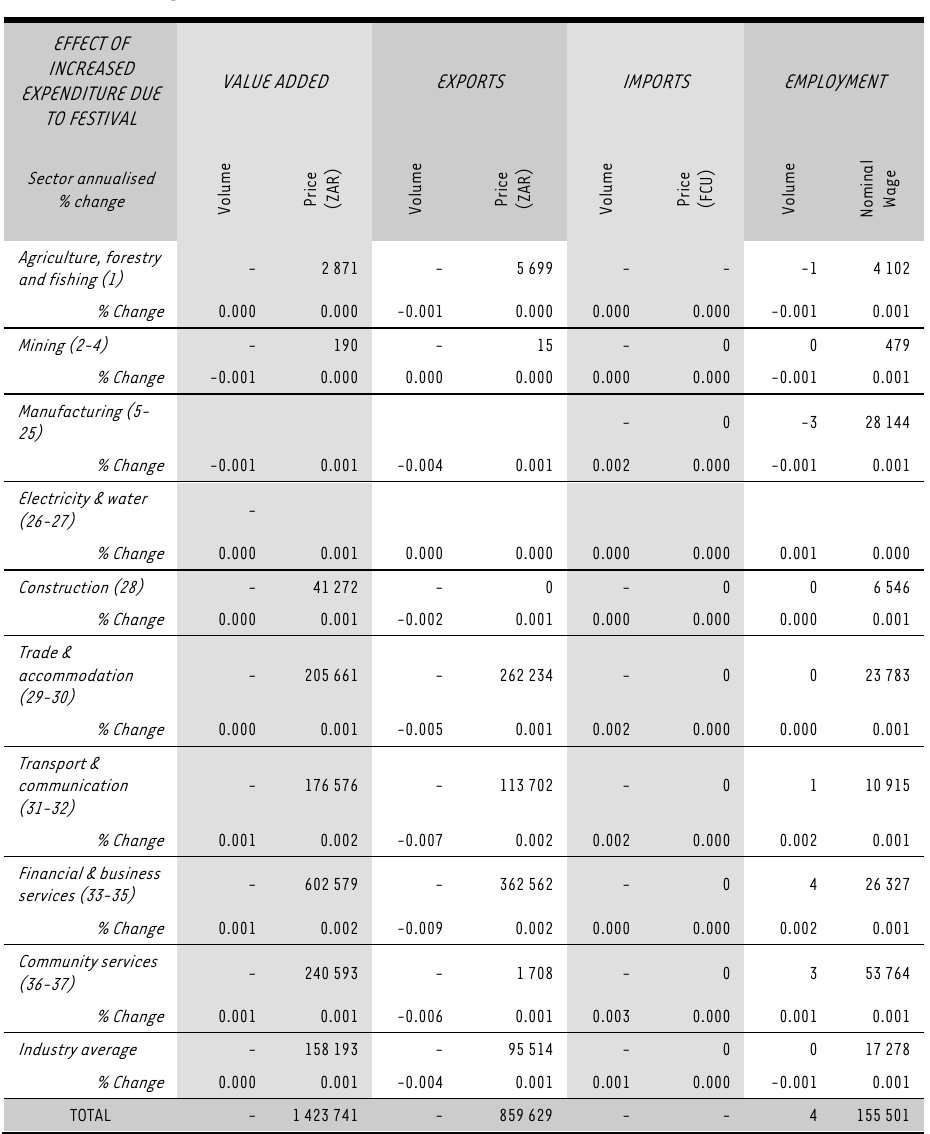
Aggregate sectoral level impacts (structural effects for the regional model only) -